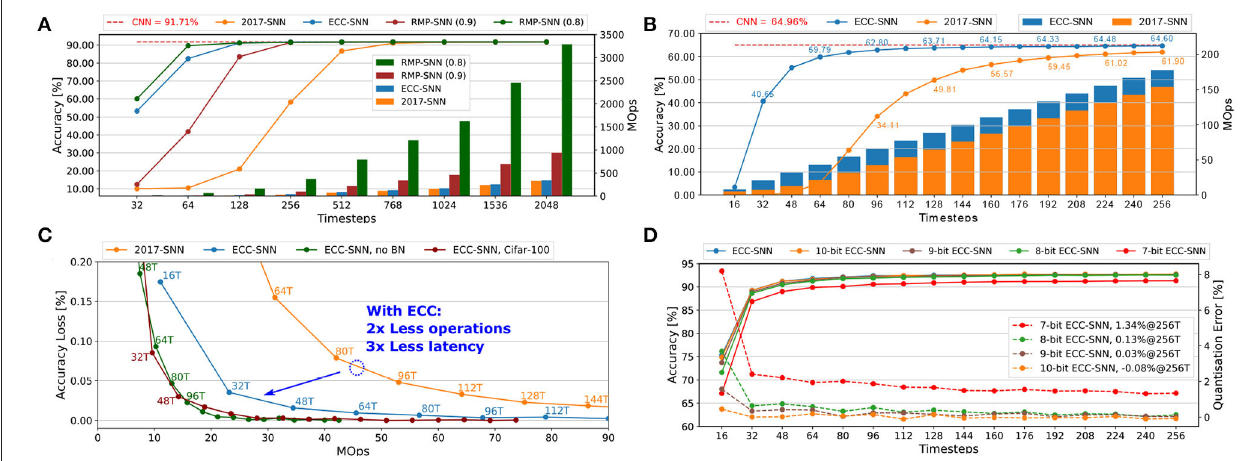
FIGURE 3 | (A) Accuracy and energy consumption (MOps) with respect to timesteps for CIFAR-10. (B) Accuracy and energy consumption (MOps) with respect to timesteps, for ImageNet (Top-1 Acc). (C) Accuracy loss and latency with respect to energy consumption (MOps), for CIFAR-10 and CIFAR-100. (D) Accuracy and quantisation error with respect to timesteps, for